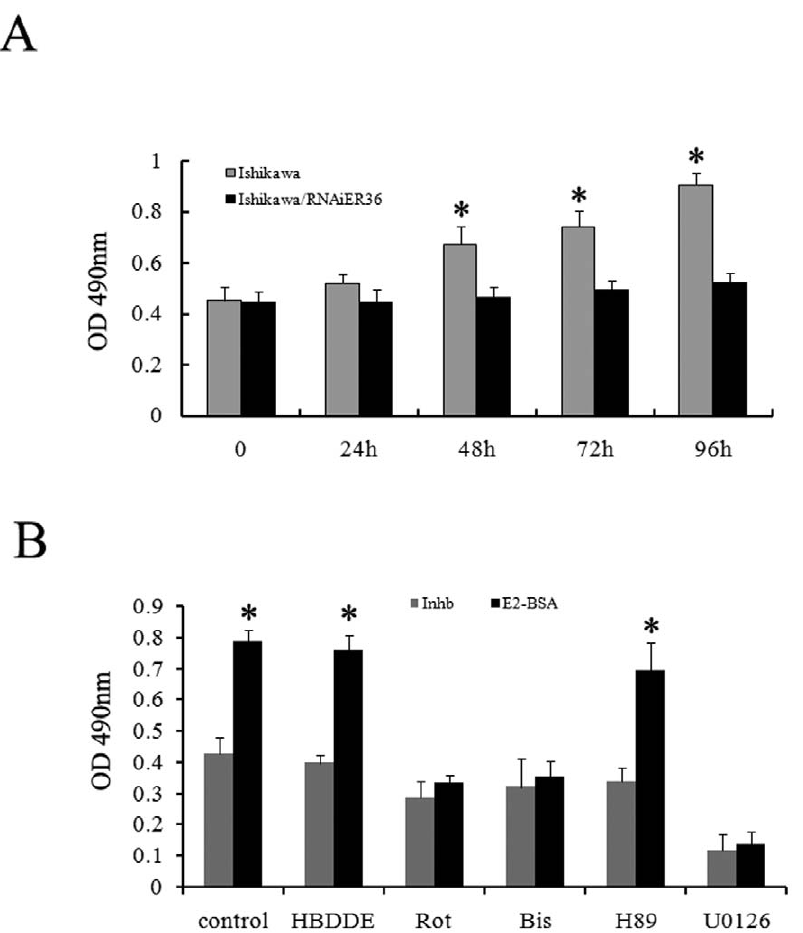
Figure 6. ER-a36 mediates E2 stimulated cell proliferation. A. Ishikawa/V and Ishikawa/RNAiER36 cells were treated with 10 nM E2-BSA for 24 h, 48 h, 72 h and 96 h. MTT assay was performed as described in the materials and methods. Results of three independent experiments were averaged and mean value 6 SEM are shown. *, P , 0.05 compared to E2-BSA treated Ishikawa/V cells respectively. B. Ishikawa cells were treated with 10 nM E2-BSA alone or together with 5 m M rottlerin, a PKC d specific inhibitor, or 5 m M bisindolylmaleimide, a pan-PKC inhibitor, or HBDDE, a PKC a specific inhibitor, or 5 m M H89, a PKA specific inhibitor for 72 h, and MTT assays were then performed. Results of three independent experiments were averaged and mean value 6 SEM are shown. *, P , 0.05 compared to control